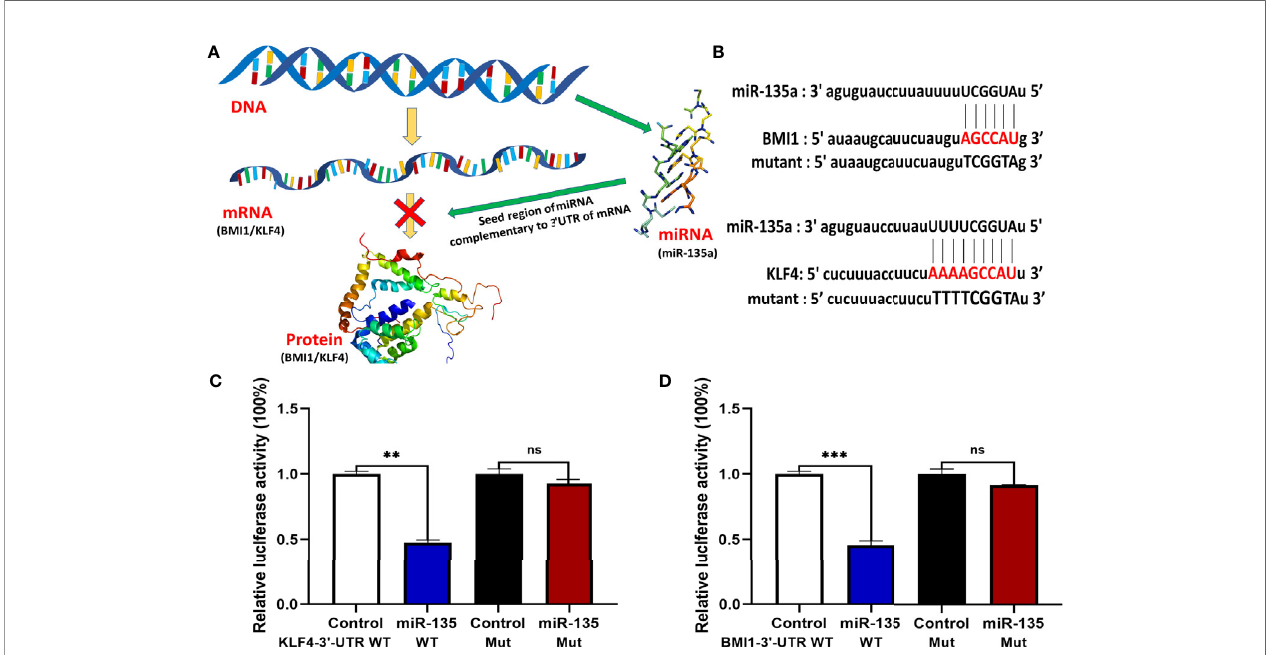
FIGURE 7 | miR-135a targeting of BMI1 and KLF4 expression in OS cells. (A) A schematic diagram illustrated how miR-135a inhibited OS progression by targeting BMI1 and KLF4 pathway. (B) Bioinformatic analysis of miR-135a targeting of BMI1 and KLF4 3 ′ -UTR. (C, D) Luciferase reporter assay. Saos-2 cells were grown and cotransfected with 10 nM of miR-135a mimic or control miR-NC and with 0.25 lg per/well of plasmids containing the 3 ′ -UTR of BMI1 and KLF4 or their mutants using Lipofectamine 3000 for 2 days and then subjected to luciferase reporter assay. (ns p >0.05; ** p < 0.01; *** p < 0.001; n = 3). The data were expressed as the mean ± SEM. ns, not signi fi